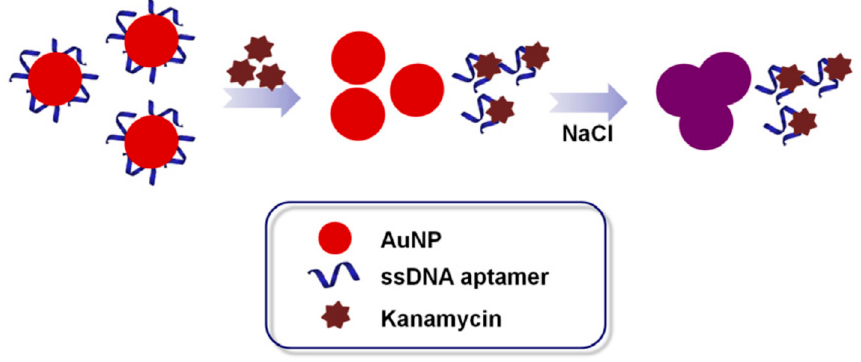
Figure 2. Schematic illustration of the AuNP-based colorimetric assay for detection of kanamycin [59].